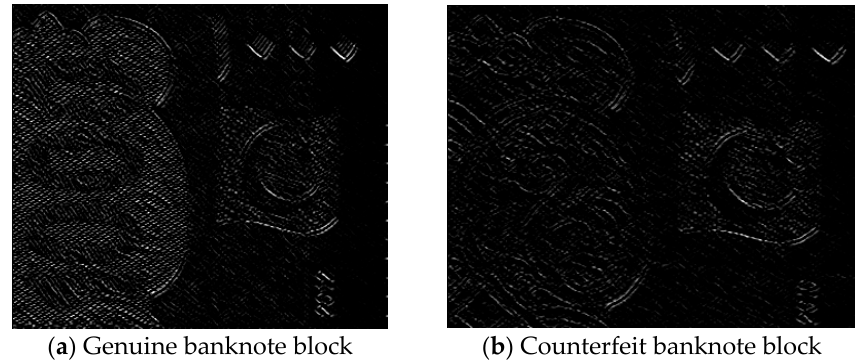
Figure 2. Derivative image of genuine and counterfeit banknotes. Figure 9. Derivative image of genuine and counterfeit banknotes.